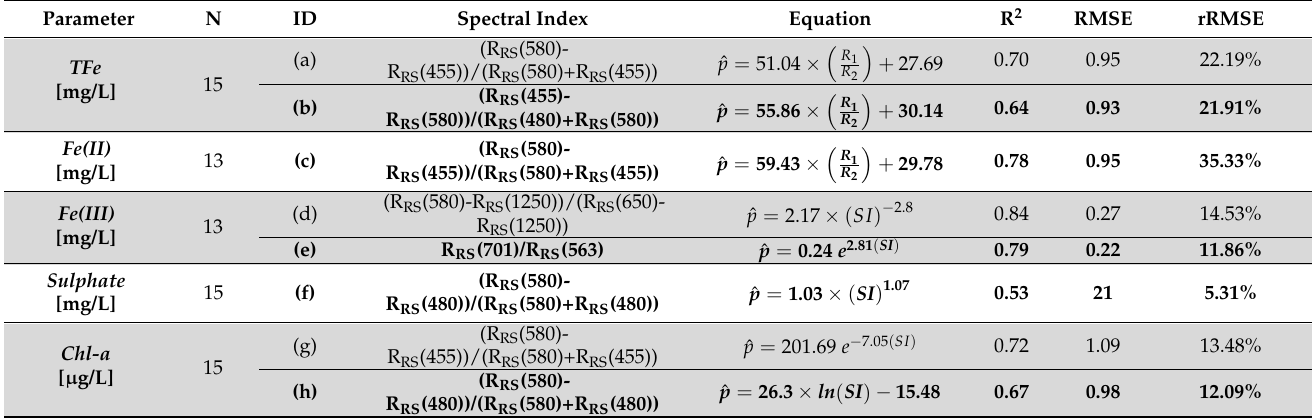
Table 3. List of the area coverage derivation results showing the number of samples used (N), the ID to link to the regression models in Figure 1, the spectral index, the regression equation, the coefficient of determination (R 2 ), the RMSE and the rRMSE. The models displayed in bold font were used in Figure 6 for the specific concentration